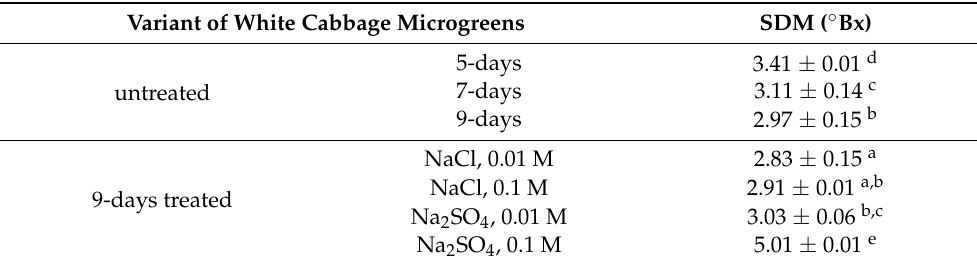
Table 1. Soluble dry matter (SDM), ◦ Bx, of untreated (5-, 7- and 9-day) and 9-day treated (with NaCl or Na 2 SO 4 ) white cabbage